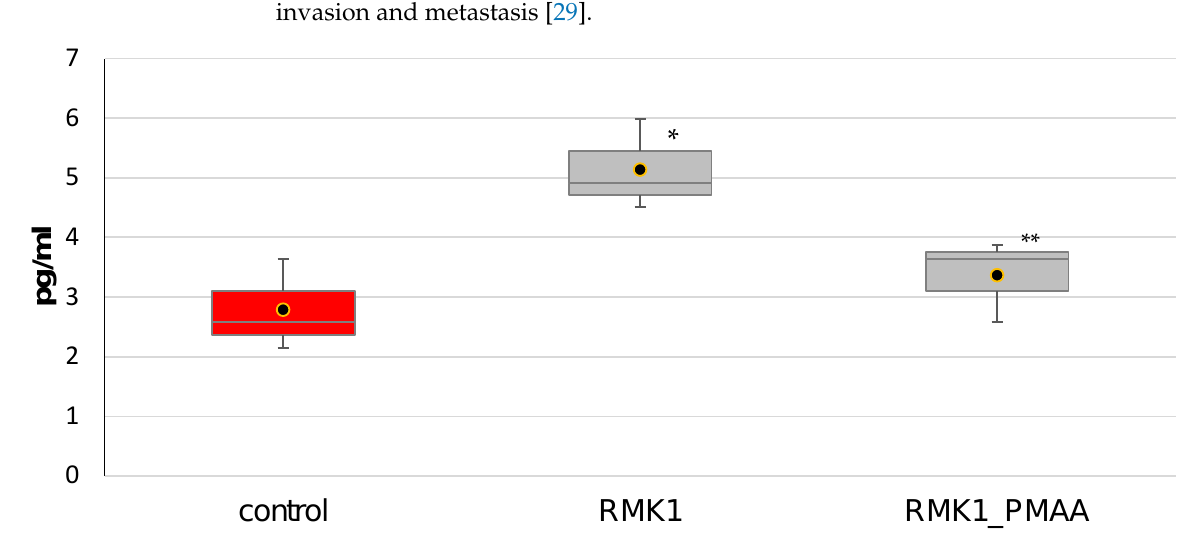
invasion and metastasis [29].